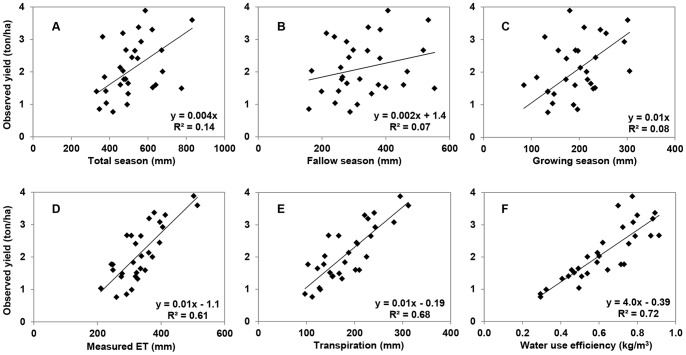
Relationships between observed yield and total rainfall (A), rainfall in fallow season (B), rainfall in growing season (C), measured ET (D), Transpiration (E) and WUE (F).The significant level is 0.028 for (A), 0.167 for (B), 0.027 for (C). For D, E and F, the significant level is all smaller than 0.01.